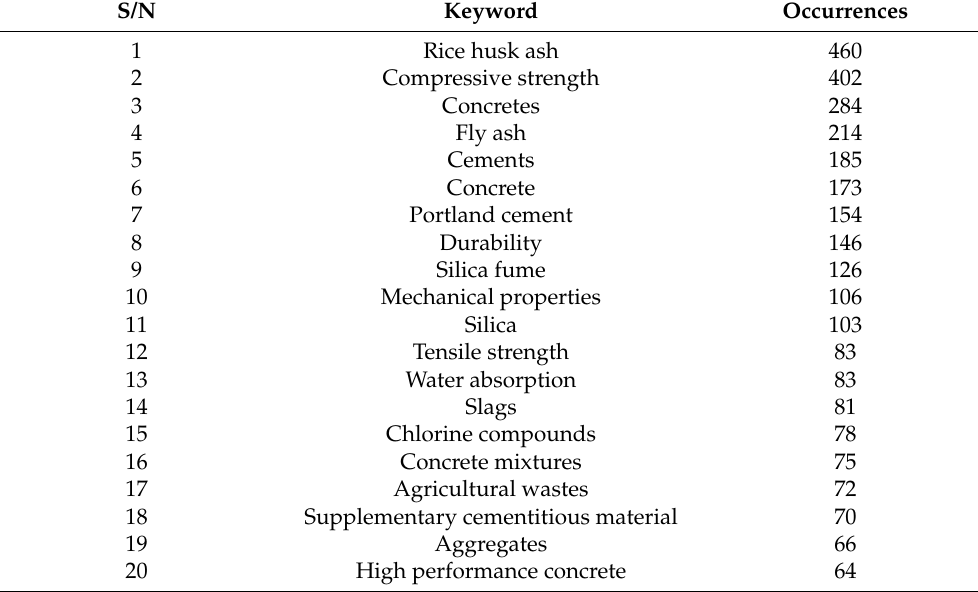
Table 2. The leading 20 frequently employed keywords in the research of RHA